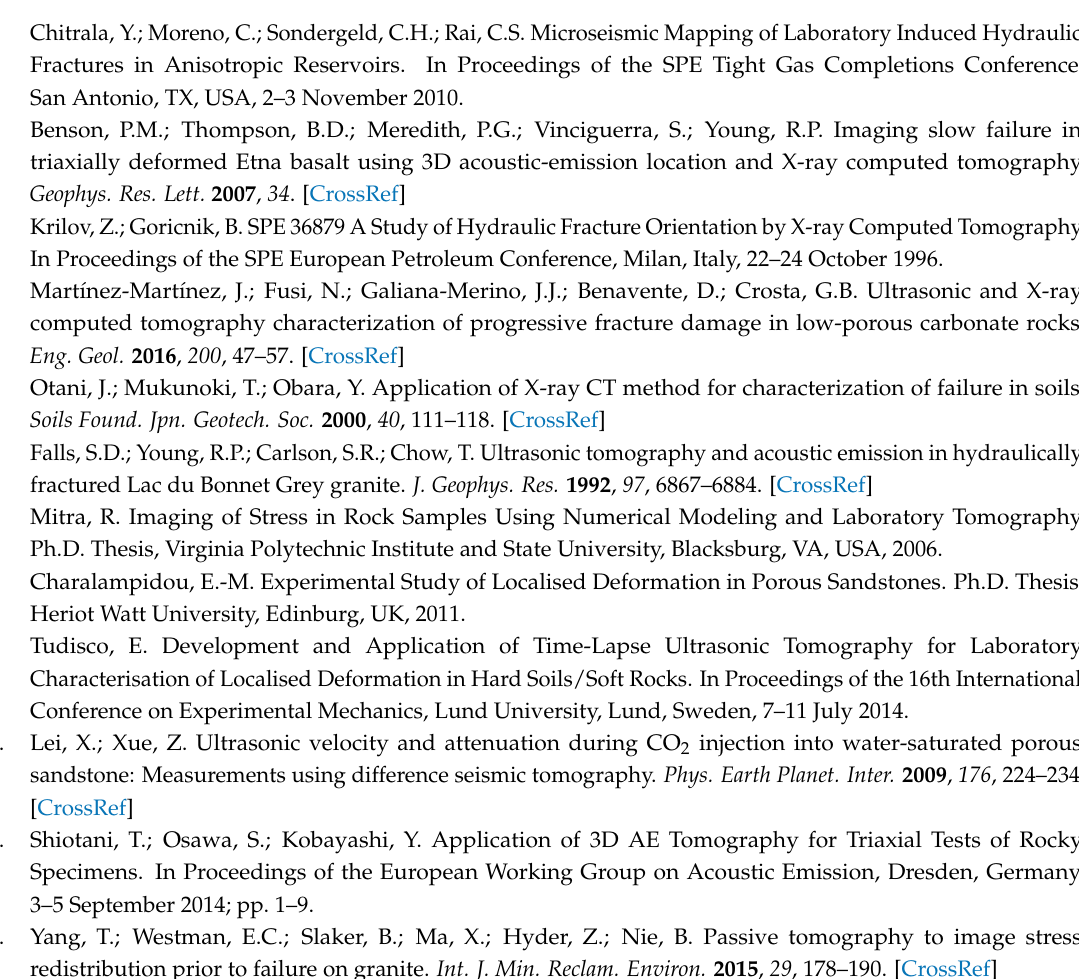
s1. Figure S1: The different views of tomographic images of Tikh (with RNL ρ = 0.1%) under sparse ray-coverage, Figure S2: The different views of tomographic images of TVR (with RNL ρ = 0.1%) under sparse ray-coverage, Figure S3: The different views of tomographic images of Tikh (with RNL ρ = 0.5%) under sparse ray-coverage, Figure S4: The different views of tomographic images of TVR (with RNL ρ = 0.5%) under sparse ray-coverage, Figure S5: The different views of tomographic images of Tikh (with RNL ρ = 1%) under sparse ray-coverage, Figure S6: The different views of tomographic images of TVR (with RNL ρ = 1%) under sparse ray-coverage, Figure S7: The different views of tomographic images of Tikh (with RNL ρ = 3%) under sparse ray-coverage Figure S8: The different views of tomographic images of TVR (with RNL ρ = 3%) under sparse ray-coverage, Figure S9: The different views of tomographic images of Tikh (with RNL ρ = 5%) under sparse ray-coverage, and Figure S10: The different views of tomographic images of TVR (with RNL ρ = 5%) under sparse